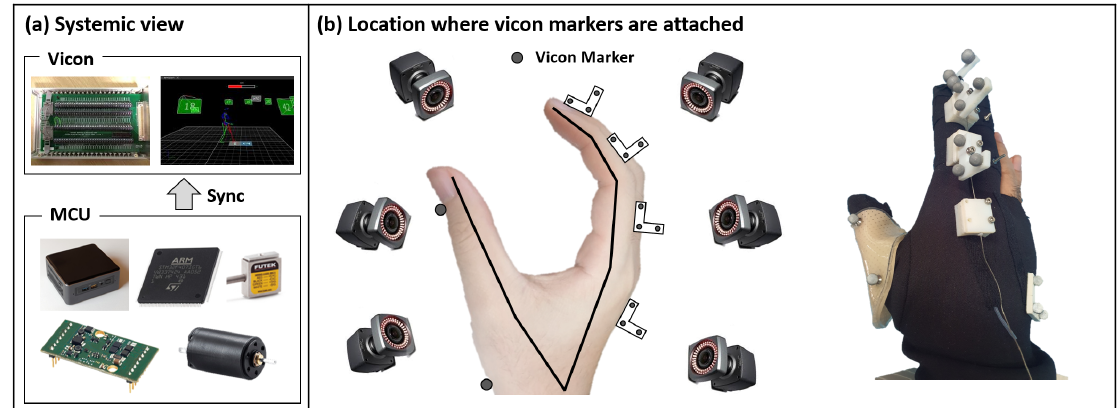
Figure 8. Schematic view of the experimental protocol: ( a ) shows a systemic view of vicon and the control system. By transmitting a sync signal to the ADC converter of the Vicon system, the loadcell data and encoder data were synchronized with the Vicon data. ( b ) shows the location where vicon markers are attached. A Total 14 markers are used in this experimental setup; 12 markers are used for the index finger and two markers are attached to the thumb to measure the thumb